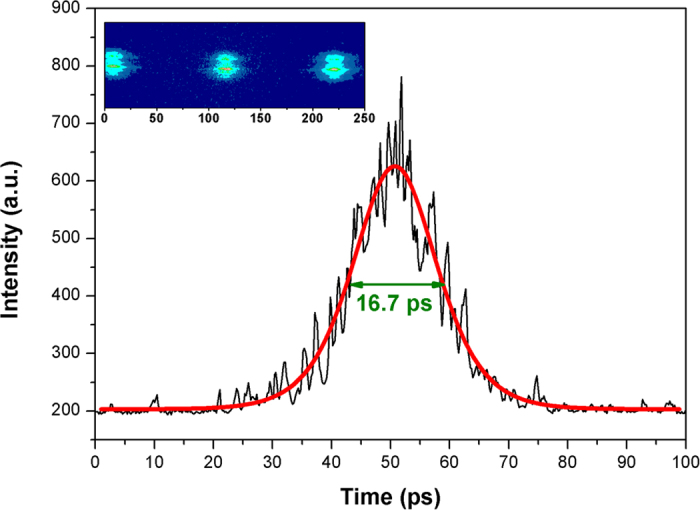
The measured streak-camera trace and sech2 fitting.